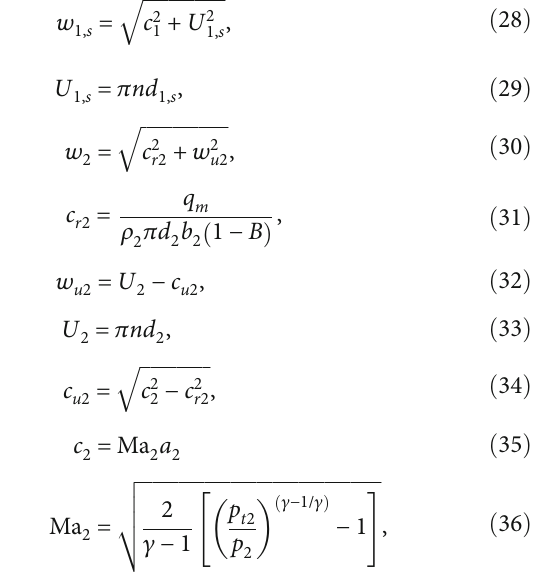
inlet w and outlet w are solved from the velocity triangles 1 , s 2 and isentropic fl ow equation as follows: